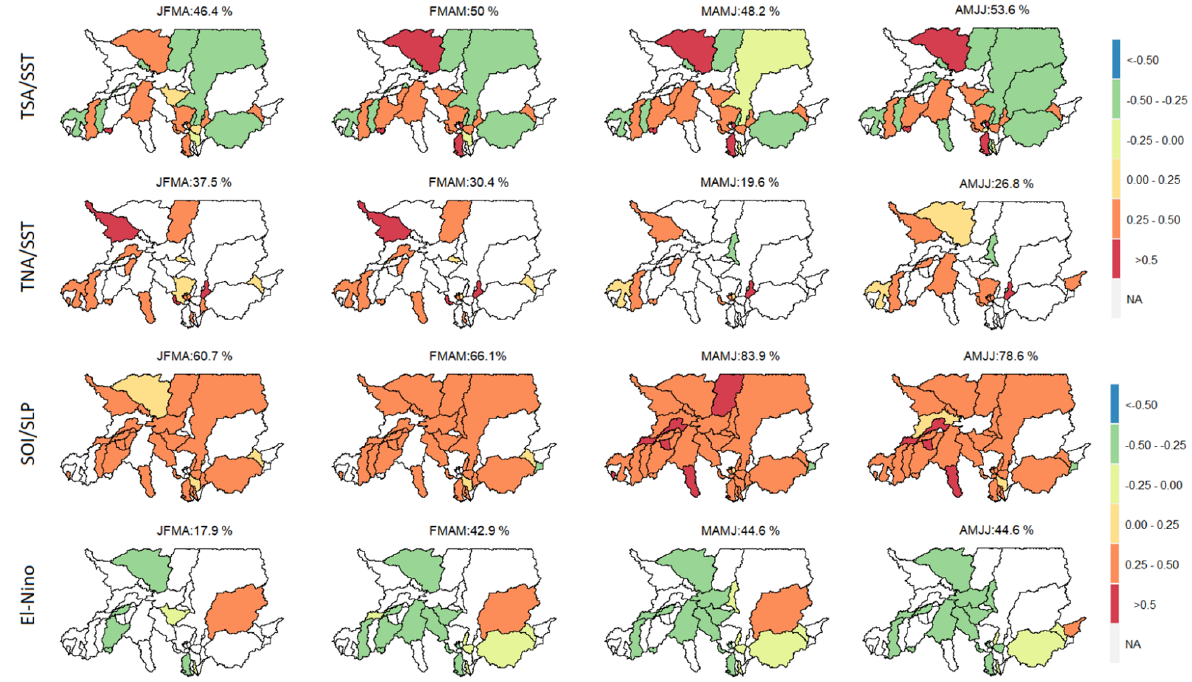
Figure 2. Correlation coefficient between the four monthly climate indexes and the logarithm of the annual maximal. Table 1. Percentage of stations with the associated sensitivity level computed using the SOI/SLP (See Fig. 3).